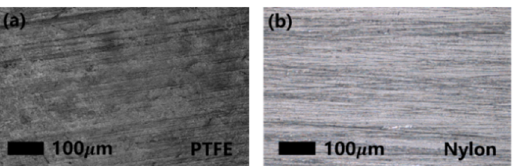
Figure A1. Flexibility diagram of hydrogels electrodes. ( i ) original state of hydrogel ( ii ) bending state of hydrogel ( iii )twisting state of hydrogel.